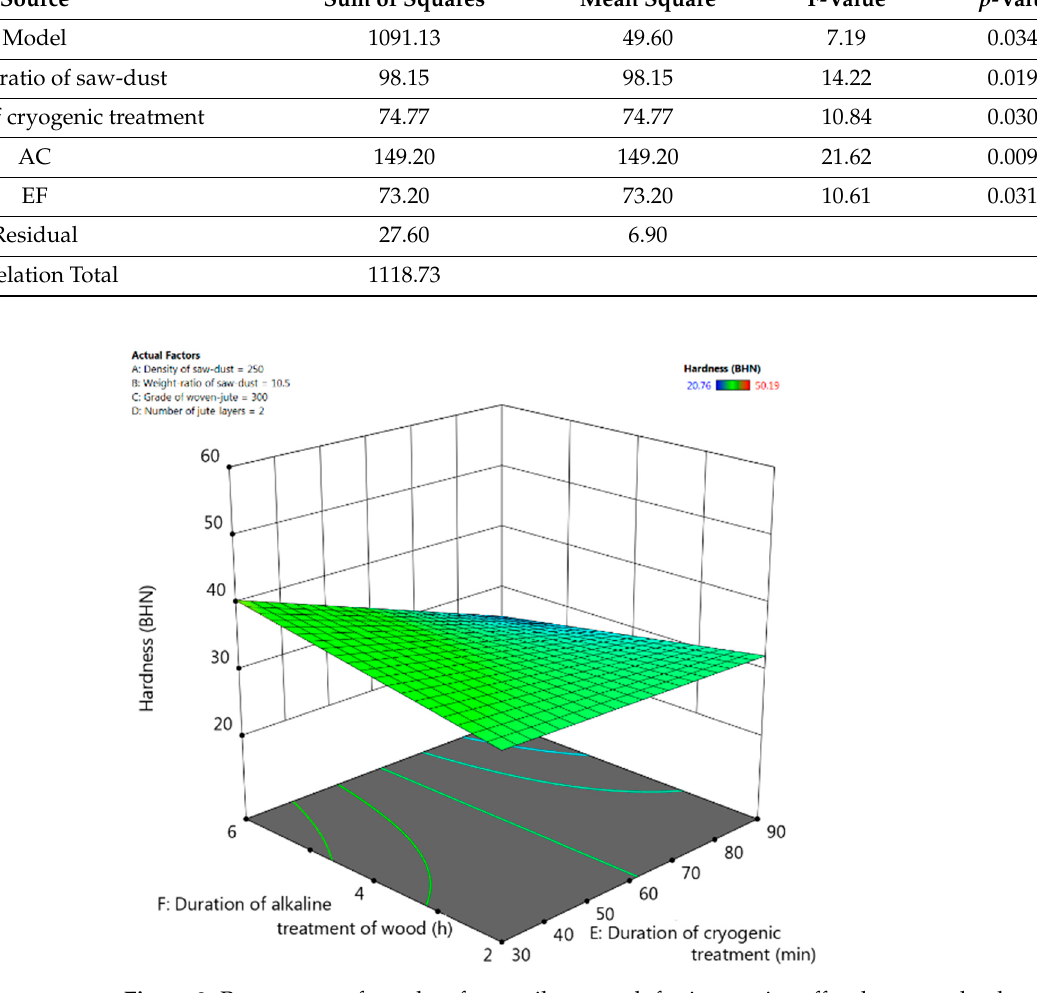
Figure 9. Response-surface plots for tensile strength for interactive effect between the duration of alkaline treatment and the duration of cryogenic treatment of composite.